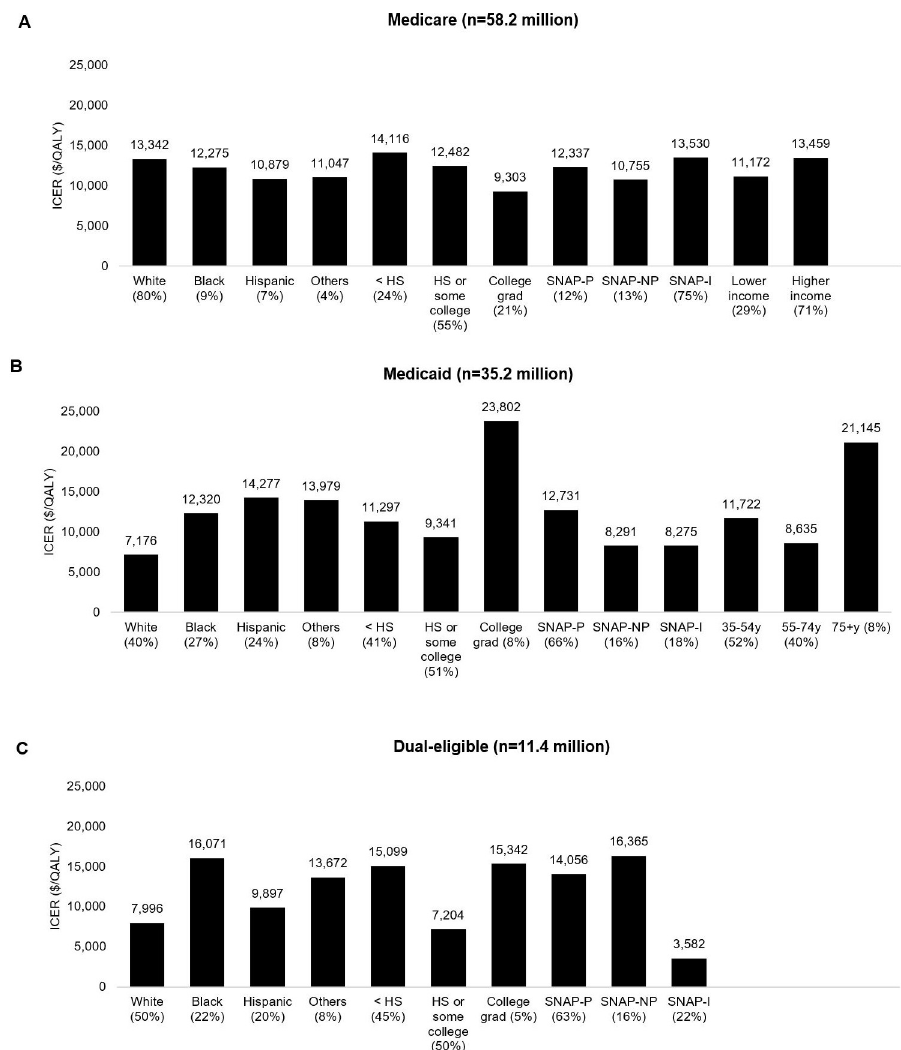
Fig 4. Lifetime cost-effectiveness of the 30% healthy food incentive program in (A) Medicare, (B) Medicaid, and (C) dual-eligible adult beneficiaries by race/ethnicity, education, SNAP, income, and age. Values are shown from a healthcare perspective. Numbers represent ICERs. ICERs were calculated as the change in net costs (policy costs minus health-related savings) divided by the net change in QALYs. Stratified analyses were conducted by race/ethnicity (non- Hispanic white, non-Hispanic black, Hispanic, other), education ( < HS, HS or some college, college graduate or above [College grad]), SNAP, and income (PIR < 1.3 or � 1.3) within Medicare; by race/ethnicity, education, SNAP, and age (35–54, 55–74, � 75 years) within Medicaid; and by race/ethnicity, education, and SNAP within dual-eligible participants. Income strata are not shown in Medicaid and dual-eligible because adults on those insurance categories are low-income individuals. HS, high school; ICER, incremental cost-effectiveness ratio; PIR, poverty–income ratio; QALY, quality-adjusted life year; SNAP, Supplemental Nutrition Assistant Program; SNAP-I, SNAP-ineligible individuals; SNAP-NP, SNAP-eligible nonparticipants; SNAP-P, SNAP